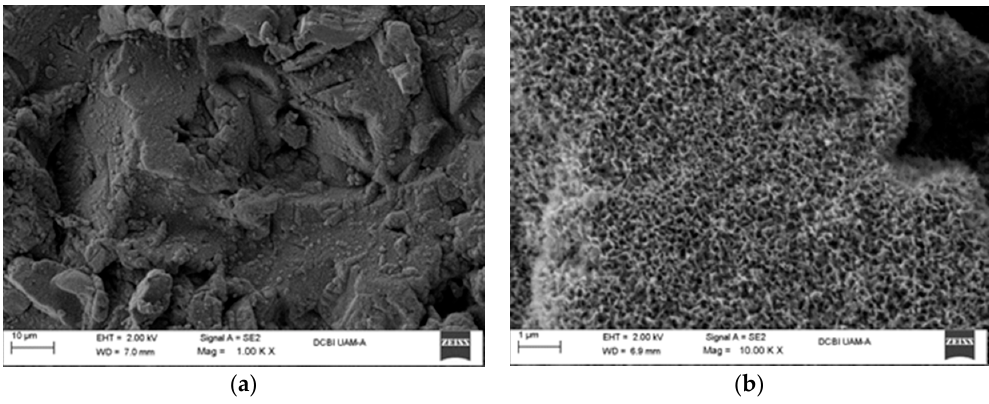
Figure 10. SEM micrographs of aluminum specimens dried for 60 min at 100 °C, ( a ) 1 K×; ( b ) 10 K×. Figure 11 shows the SEM and EDS mapping of the elements at 5 K× magnification: the micrograph presents a homogeneous dispersion of carbon (b), oxygen (c), and silicon (e) over the aluminum surface (d) after the drying process.